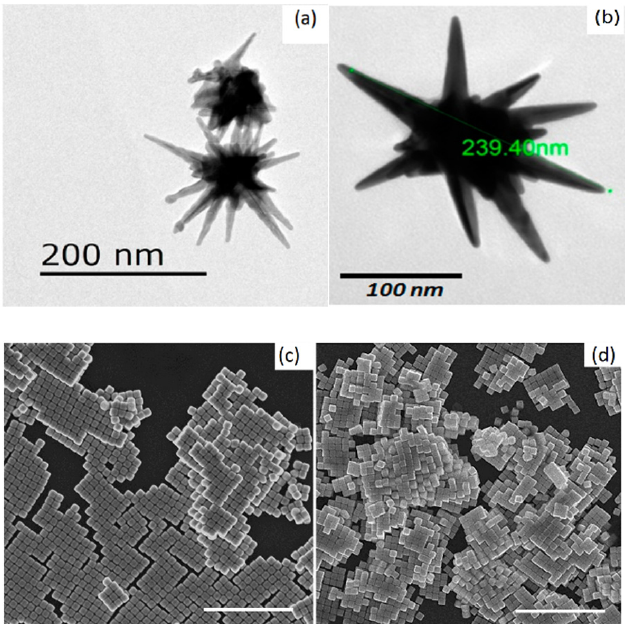
Figure 5. ( a , b ) AuNSs TEM images, reproduced and adapted with permission from [161] and [162] respectively. ( c , d ) AuNCs TEM images adapted with permission from [74]. Copyright (2018), American Chemical Society; The scale bars in the ( c , d ) images are 1 µm.